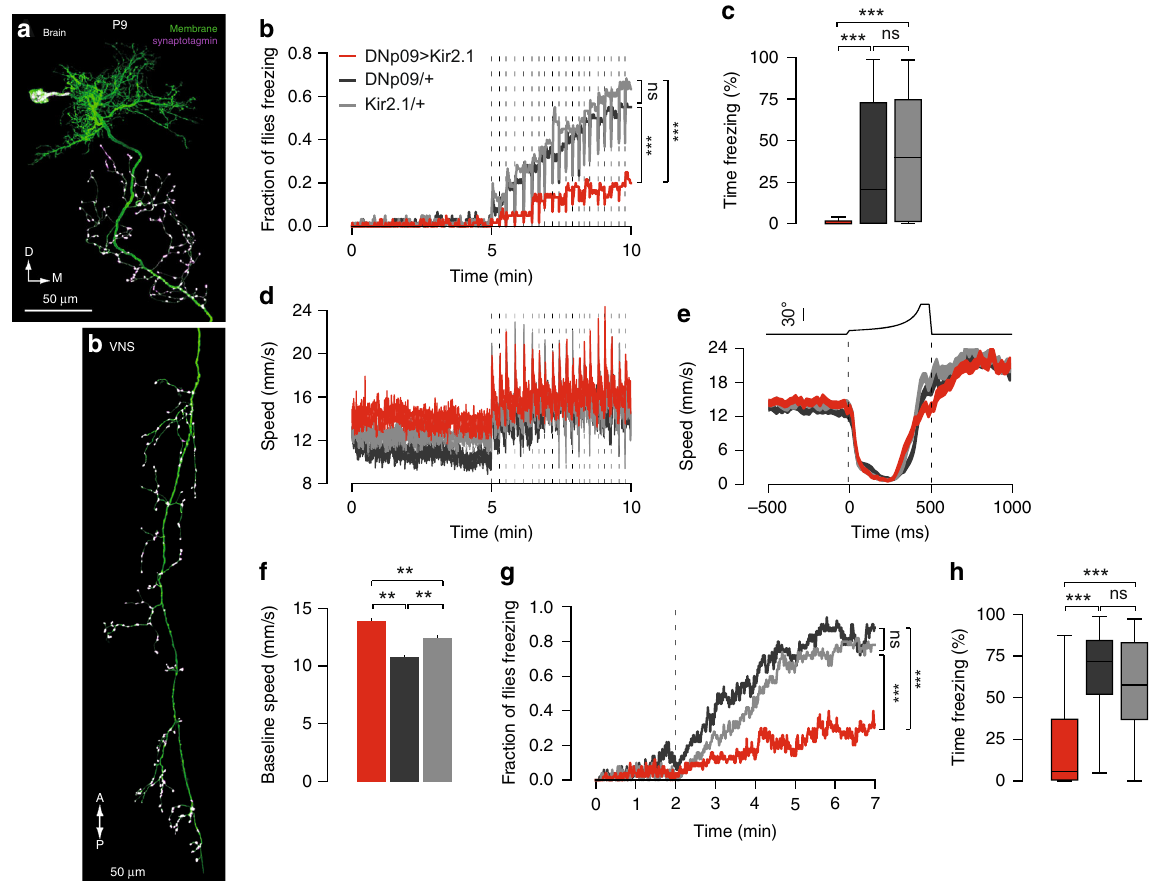
Fig. 5 Silencing DNp09 neurons disrupts freezing but not running. a DNp09 morphology. DNp09 split-GAL4 driving membrane-bound GFP (green) combined with anti-synaptotagmin-HA staining (purple). In b – h , red corresponds to DNp09 > Kir2.1 fl ies, dark gray to DNp09/ + fl ies and light gray to Kir2.1/ + fl ies. In b – d , n = 60 fl ies for each condition. b Proportion of freezing fl ies. Dashed lines represent stimulus presentations. c Percent time spent freezing during stimulation period. d Average (±s.e.m.) fl y speed including only time periods classi fi ed as walking. Dashed lines indicate stimulus presentations. e Looming-triggered speed pro fi le (average± s.e.m.) of walking trials that include a pause (DNp09 > Kir2.1 n = 234, DNp09/ + n = 253, Kir2.1/ + n = 259). f Average ( + s.e.m.) speed during baseline period ( n = 60 for all conditions). In g – h , n = 50 fl ies for each group. g Proportion of freezing fl ies for low speed closed-loop looming stimulation. Dashed line indicates onset of stimulus presentations. h Percent time spent freezing during stimulation period for closed-loop experiment. ** denotes p < 0.01, *** denotes p < 0.001, ns not signi fi cant. Box plot elements: center line, median; box limits, upper (75) and lower (25) quartiles; whiskers, 1.5x interquartile